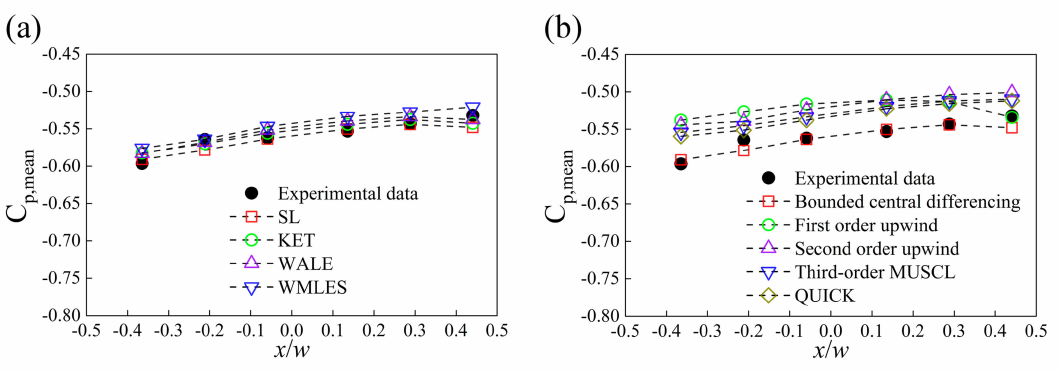
Figure 5. Comparison of mean pressure coe ffi cients along the roof centerline obtained with ( a ) four subgrid-scale models and ( b ) five discretization